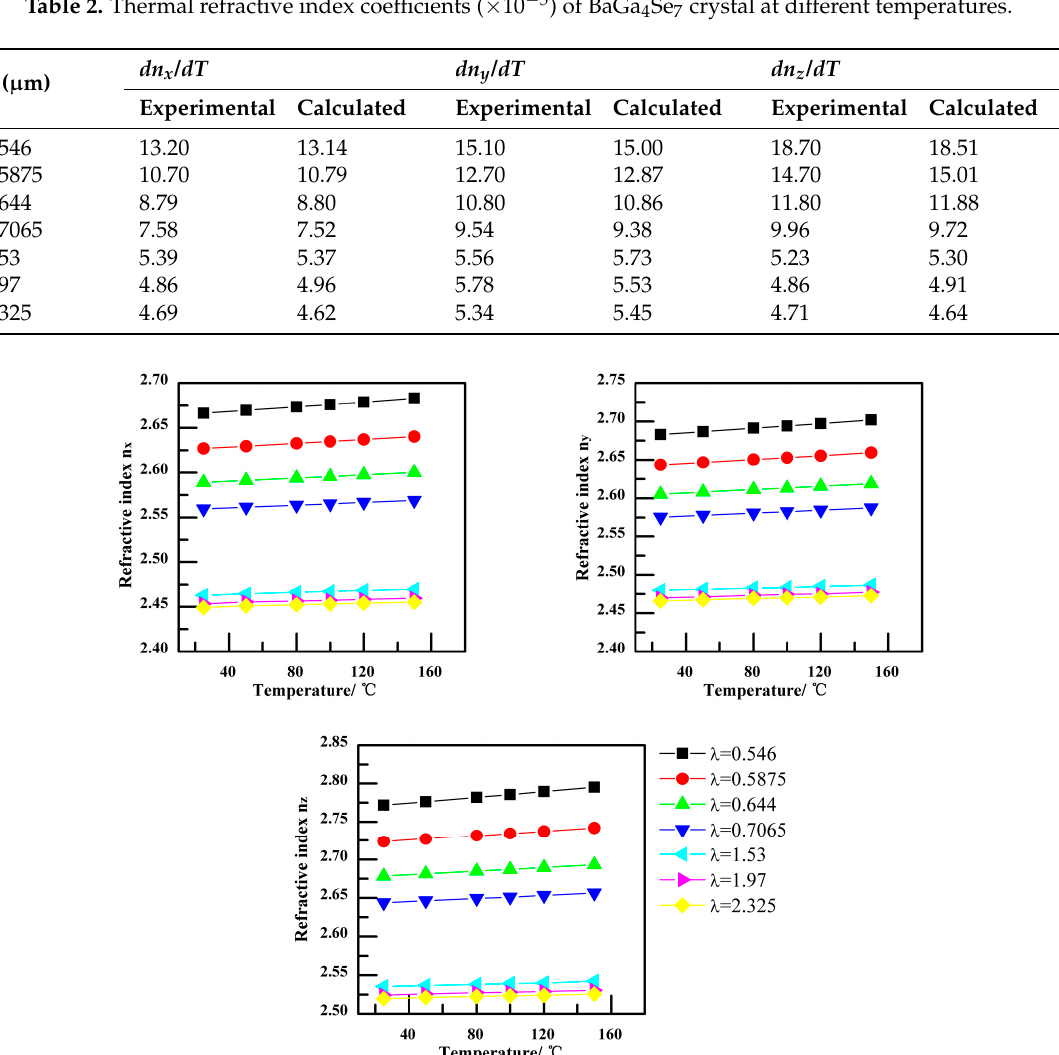
Figure 1. Theoretical and measured values of n x , n y , and n z .